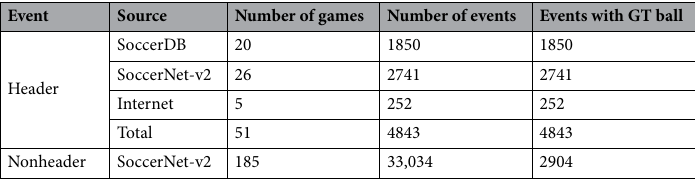
Table 2. Number and source of events in header